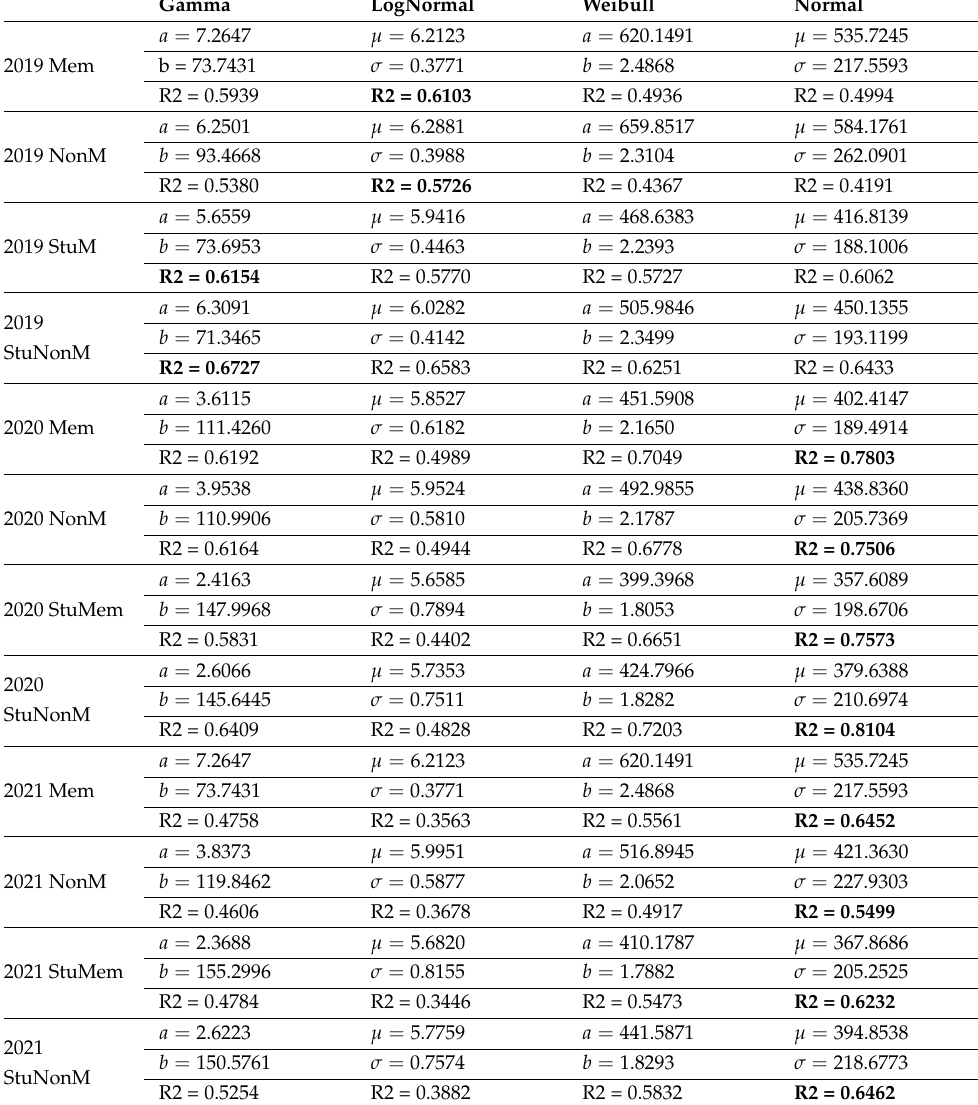
Table A6. Parameters for the fitted probability distribution functions. R2 is the r-square